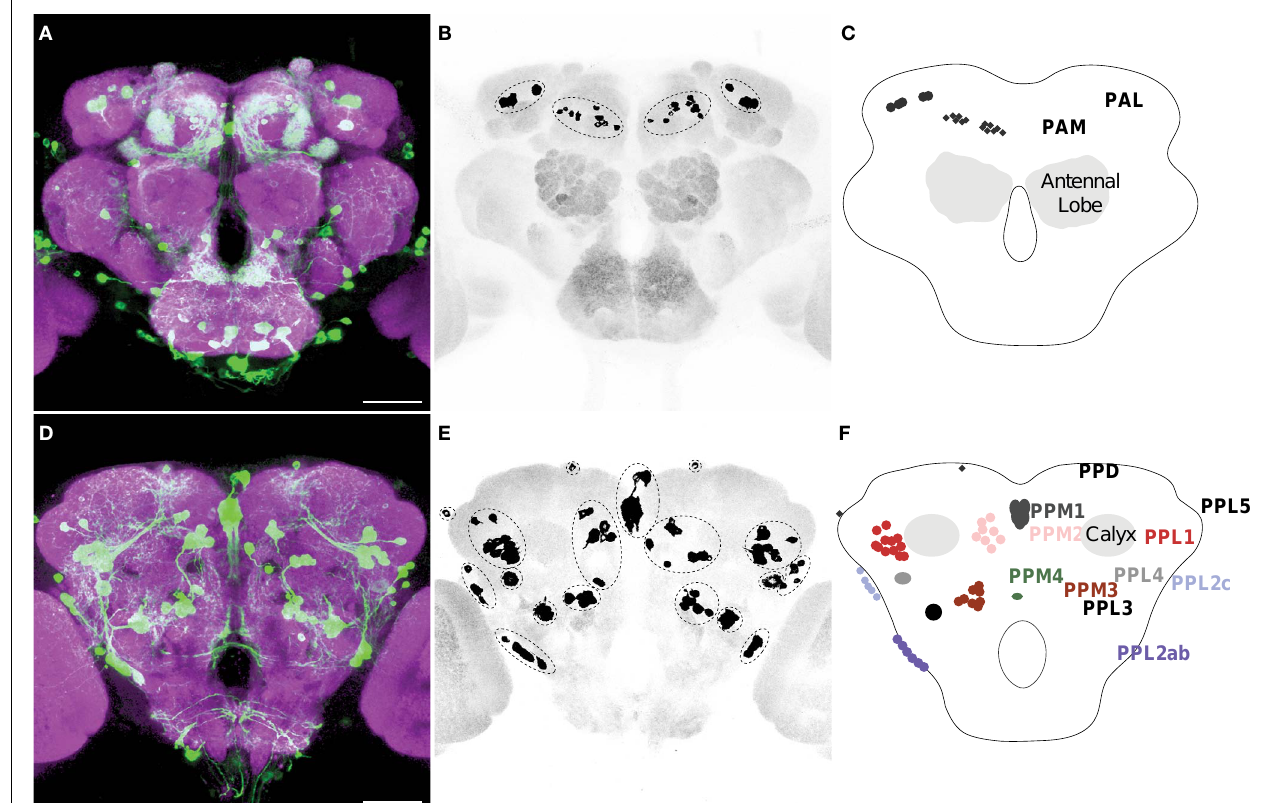
FIGURE 1 | TH-GAL4 expressing neurons in the Drosophila brain as visualized with TH-GAL4>UAS-mCD8::GFP. (A–C) Anterior view. (D–F) Posterior view. (A,D) Anti-GFP staining (green) showing cell bodies and processes of TH-GAL4 expressing cells. The brain was counterstained (magenta) with an anti-nc82 antibody. Scale bar, 50 µm. (B,E) The cell bodies were identifi ed in the protocerebrum by thresholding images taken from the brains shown in panels (A) and (D) . Dotted lines encircle groups of cells. (C,F) Schematic diagram of (B,E) indicating the name, location and typical number of TH-GAL4 expressing cell clusters in the protocerebrum (Tanaka et al., 2008). The protocerebral anterior medial (PAM) cluster resides near the anterior face of the brain in the anterior inferiormedial protocerebrum. The protocerebral anterior lateral (PAL) cluster is lateral to the dorsal portion